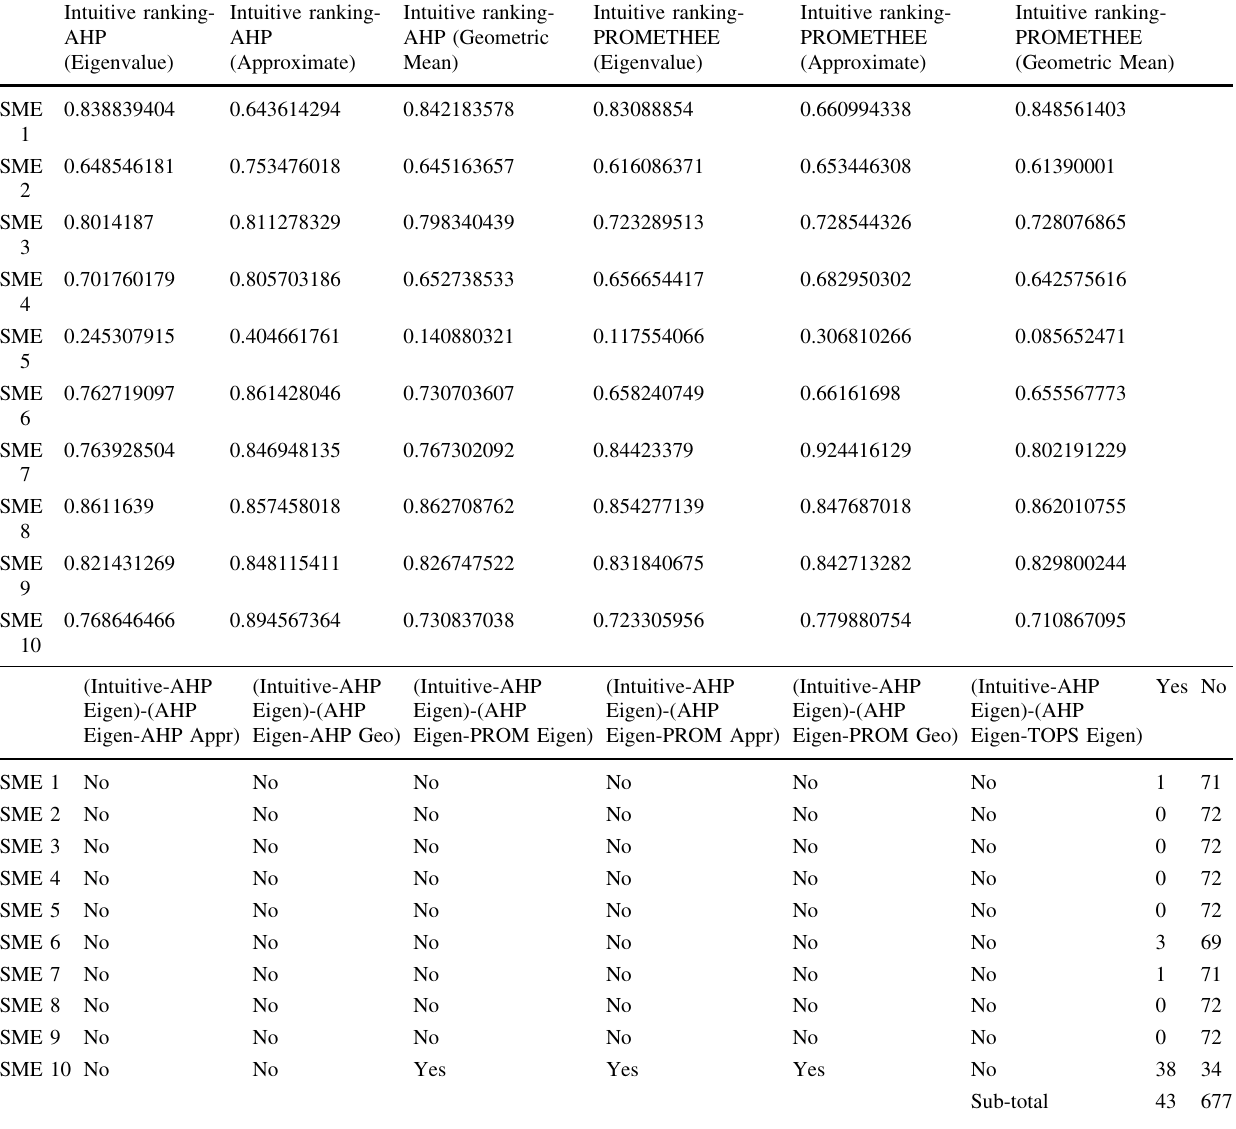
Table 22 Summary Pearson’s product–moment correlation coefficients Intuitive ranking-